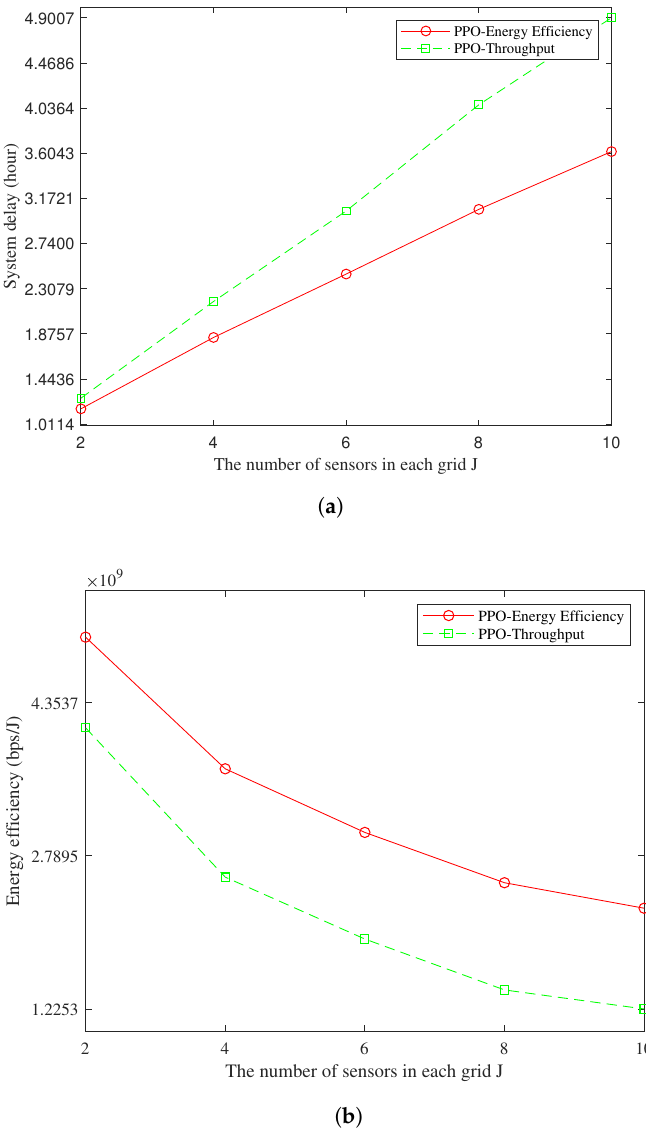
Figure 3. System performance with the number of sensors in each grid. ( a ) System delay with the number of sensors in each grid; and ( b ) Energy efficiency with the number of sensors in each